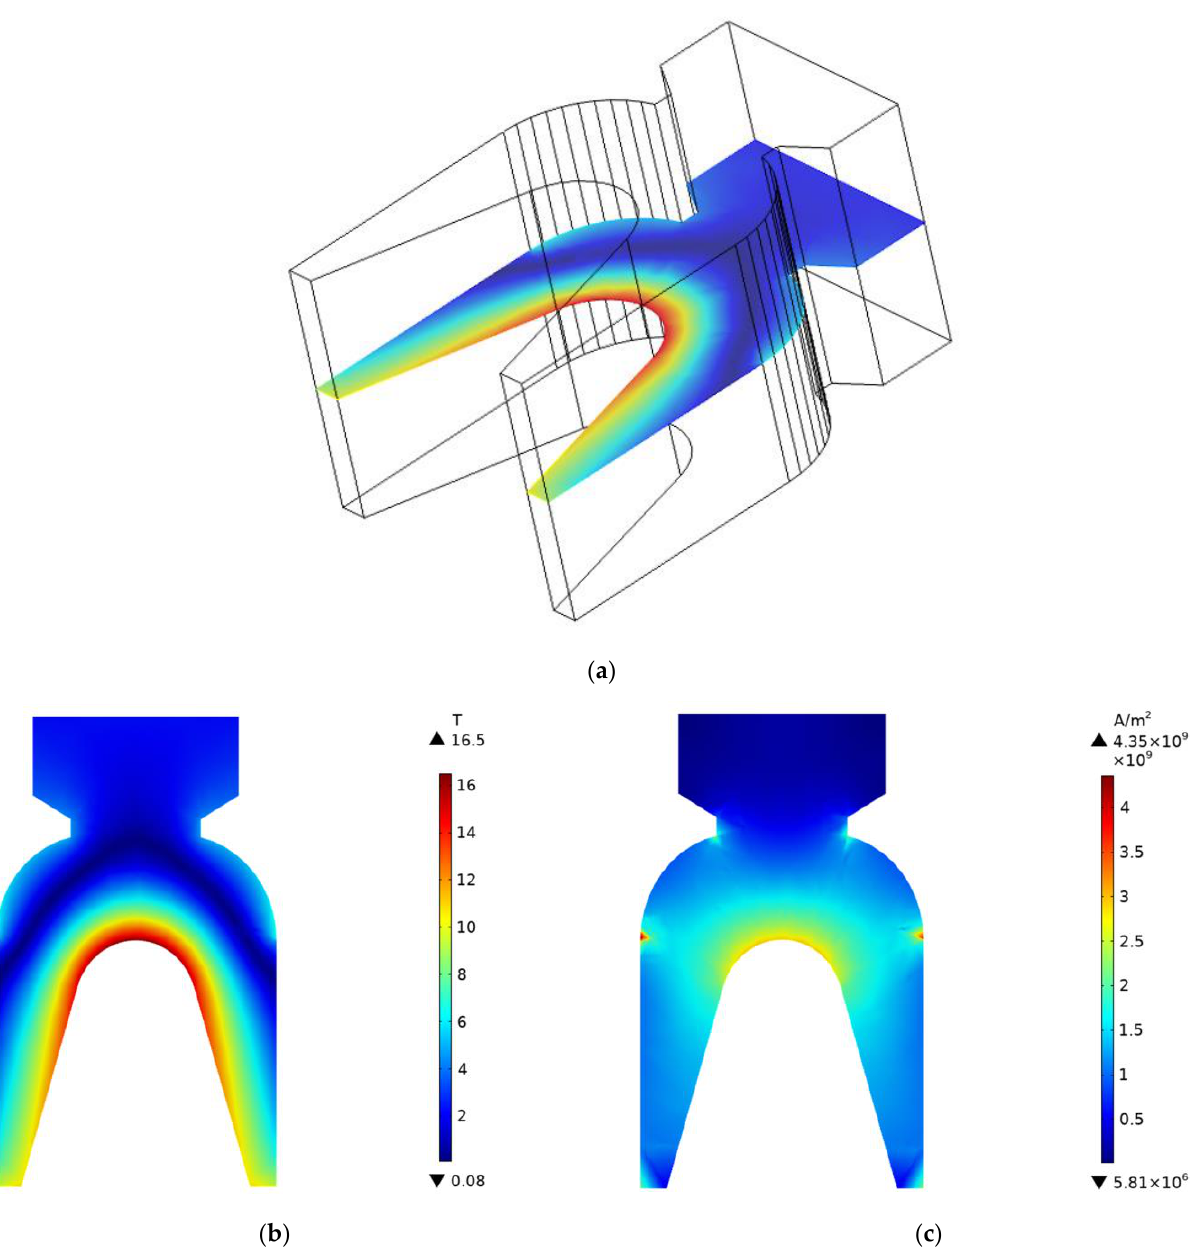
Figure 5. The numerical simulation results of the electromagnetic field on armature horizontal cross-section at 1.2 ms. ( a ) Observation angle. ( b ) Magnetic flux density on armature horizontal cross-section. ( c ) Current density distribution on armature horizontal cross-section.